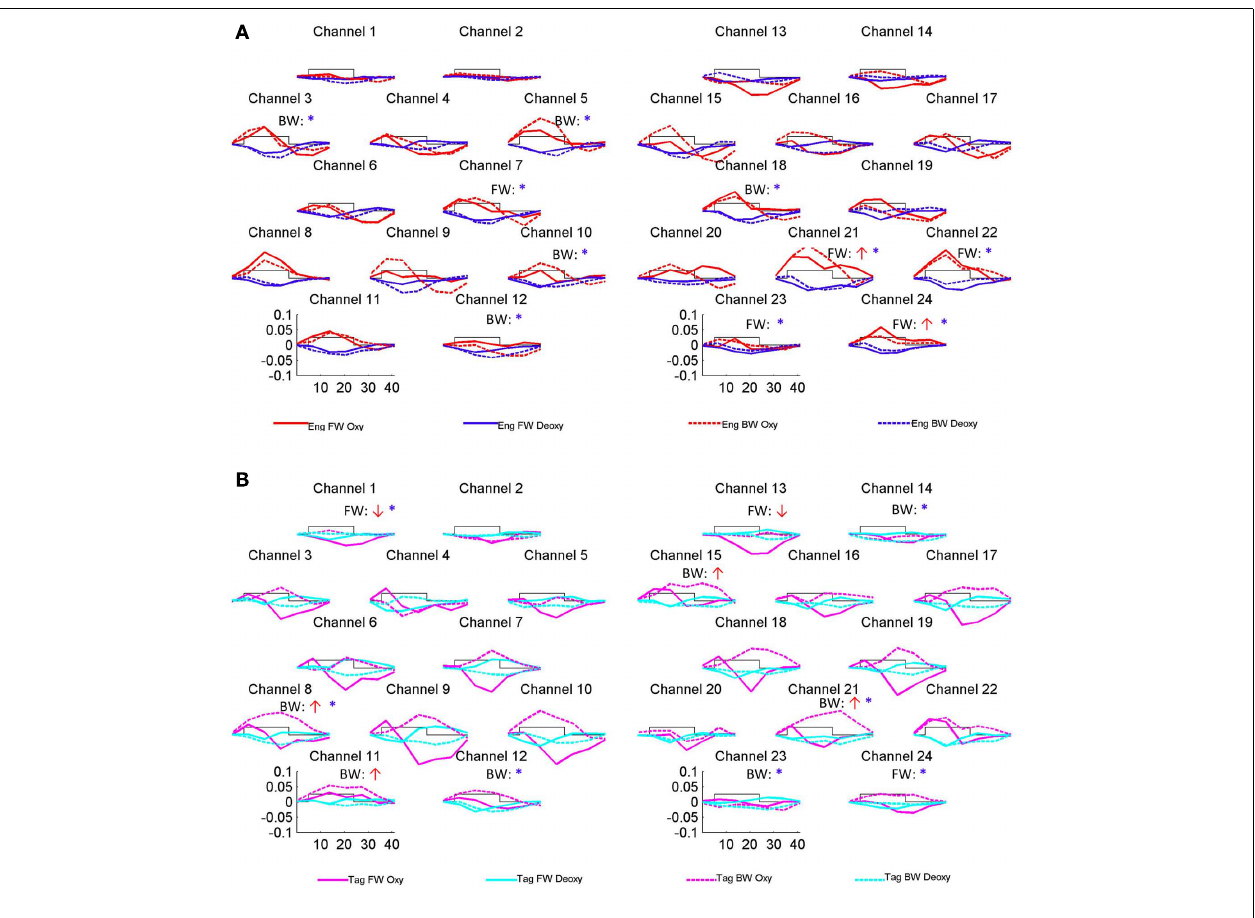
upward arrow indicates significant increase in oxyHb (canonical response), the red downward significant decrease in oxyHb (inverted response), the blue asterisk a significant decrease in deoxyHb (canonical response). After correction for multiple comparisons, using the False Discovery Rate as defined by Benjamini and Hochberg (1995), none of these comparisons reached significance.The channel-wise results are therefore only